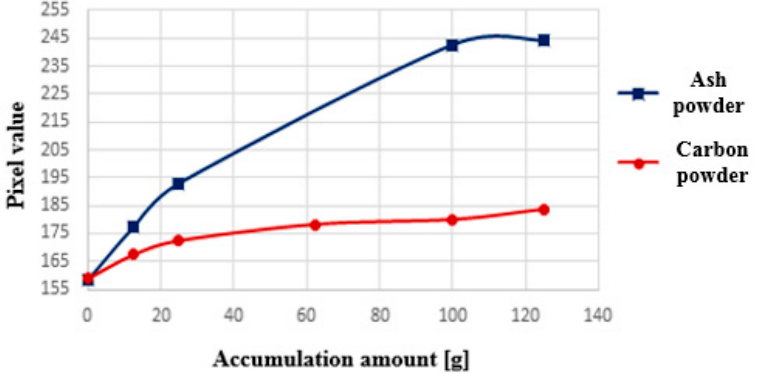
Figure 10. Pixel values comparison of carbon powder and ash powder.